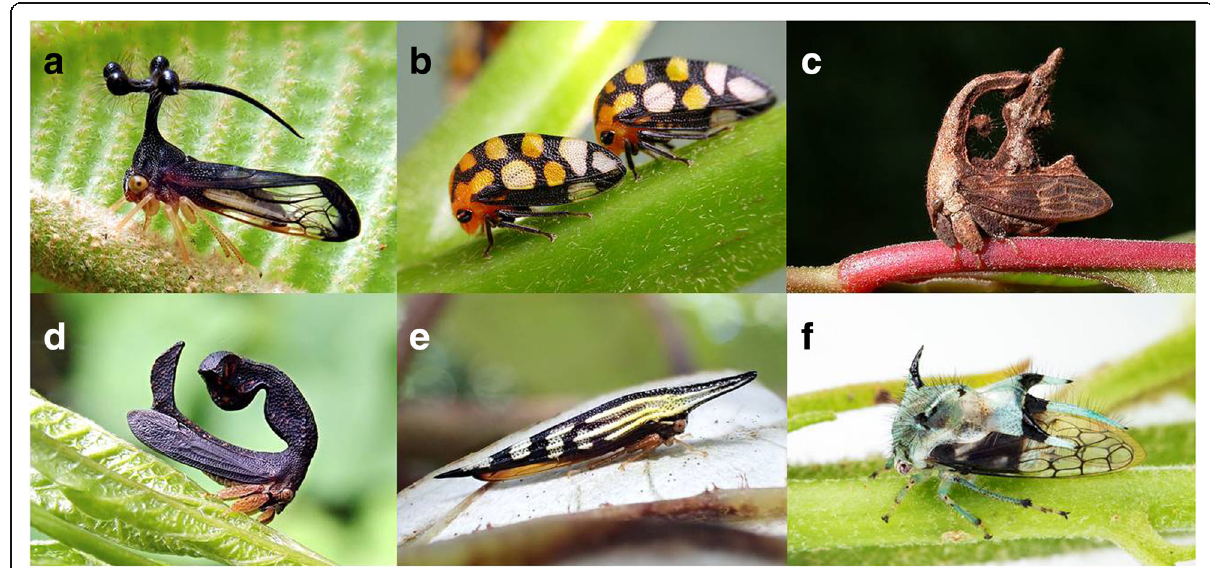
Fig. 1 Various 3D morphologies of treehopper helmets. The morphology and color of treehopper helmets show a wide diversity. All species shown here occur in Costa Rica: a Bocydium mae. b Addipe zebrina, c Cladonota biclavata, d Cladonota sp., e Polyglypta sp. , f Poppea